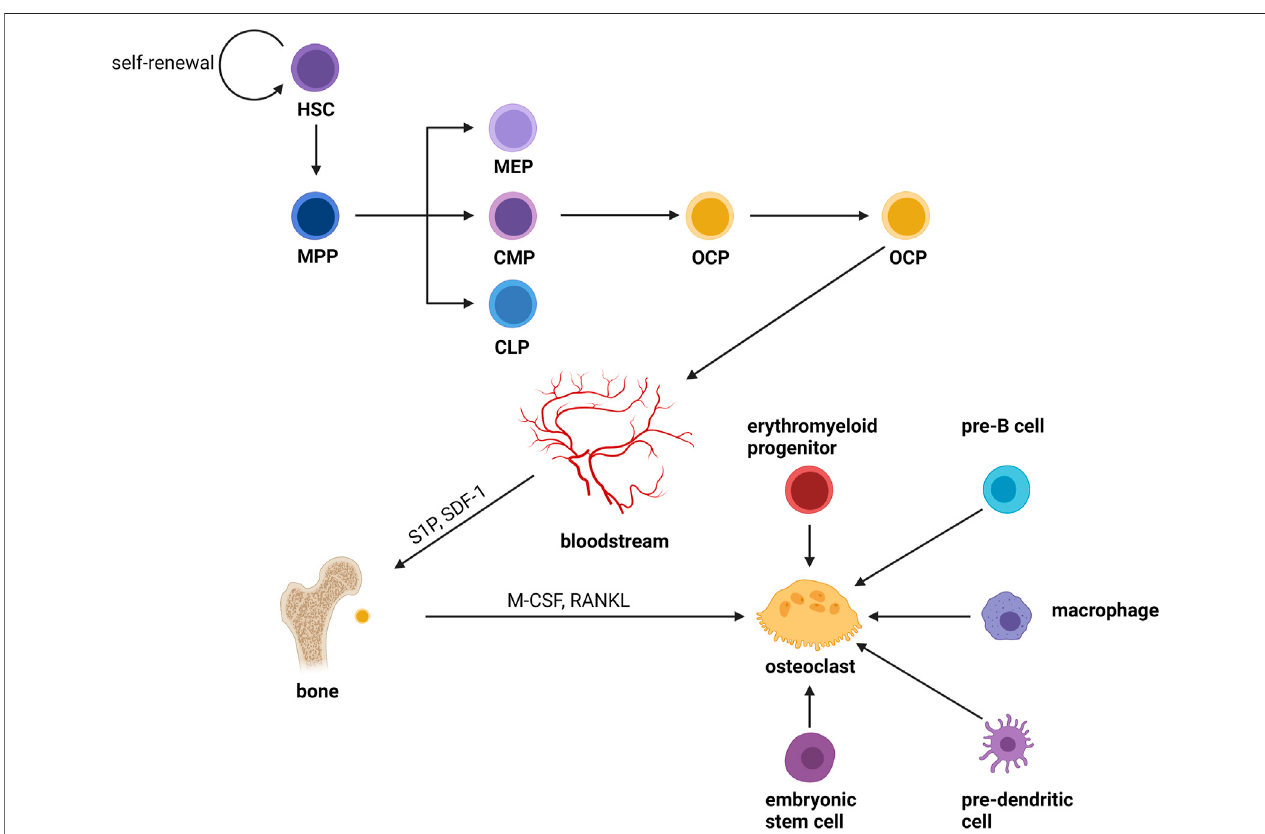
FIGURE1 | Osteoclast differentiation. Osteoclasts are formed by the fusion of OCPs from the monocyte/macrophage lineage of the bone marrow which is produced from hematopoietic stem cells (HSCs). HSCs do not form mature cells directly; instead, they yield a variety of oligopotent progenitor cells, which then differentiate into lineage-speci fi c progenitor cells, building a hierarchy branching tree. HSCs drop their ability to self-renew and transform into multipotent progenitors (MPPs) with pluripotency. After a series of divergences, MPPs become oligopotent progenitors, which include common myeloid progenitors (CMPs), megakaryocyte – erythrocyte progenitors (MEPs), and common lymphoid progenitors (CLPs). Pre-monocytes originate from CMPs and further develop into OCPs. Then, OCPs enter the blood circulation and recruit to bone remodeling units (BRUs) under the action of factors like sphingosine-1- phosphate (S1P) and stroma-derived factor 1 (SDF-1). Finally, the mature osteoclasts were formed by the cellular fusion of OCPs in the BRUs in the stimulation of factors such as M-CSF and RANKL. Furthermore, in the in fl ammatory and immunological environment, monocytes or tissue-speci fi c macrophages (macrophages that dwell in tissues) are an important source of osteoclasts. In the fetus, erythromyeloid progenitors are responsible for forming osteoclasts involved in hematopoiesis and fracture repair. Previous studies had shown that primary cells like embryonic stem cells, pre-B cells and pre- dendritic cells can also form